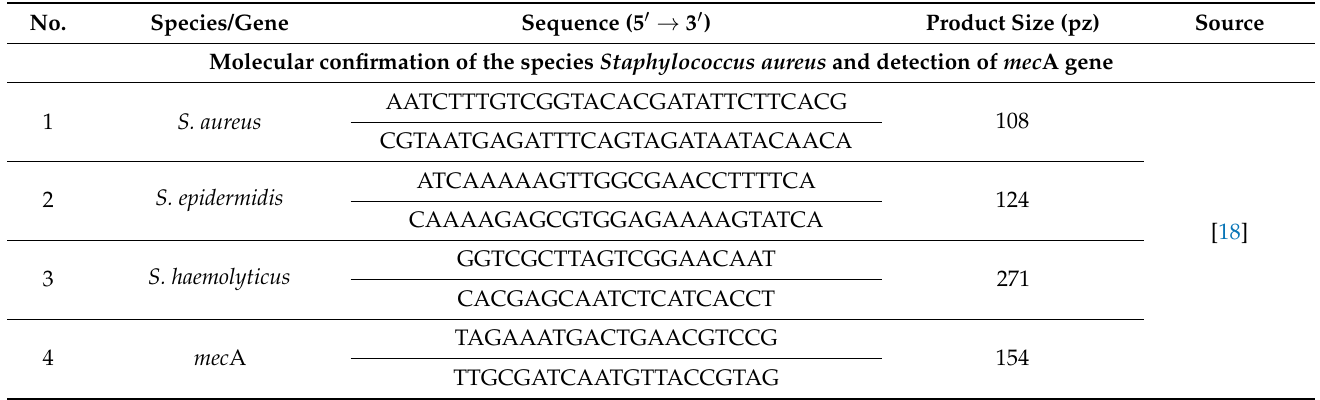
Table 1. Primer sequences used in the